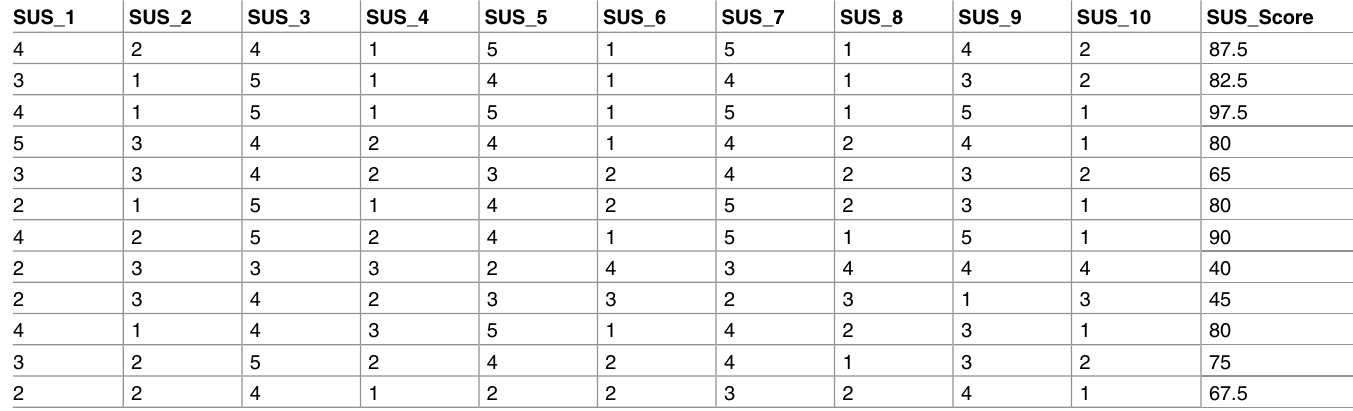
Table 1. Results of the System Usability scale in the last evaluation